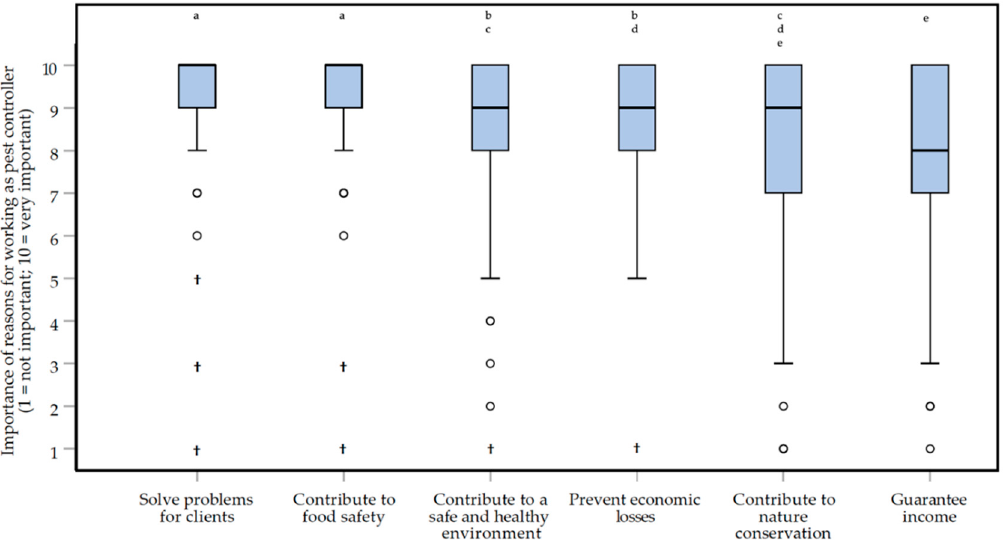
Figure 10. Box plots presenting the importance of the reasons to work as a pest controller on a 1 (not important) to 10 (very important) rating scale. Reasons to work as a pest controller were scored by 129 Dutch pest controllers, participating in an online survey about the treatment of rats ( Rattus rattus and Rattus norvegicus ) and mice ( Mus musculus ). Differences between the two reasons that are not statistically significant are indicated with letters above the bars.